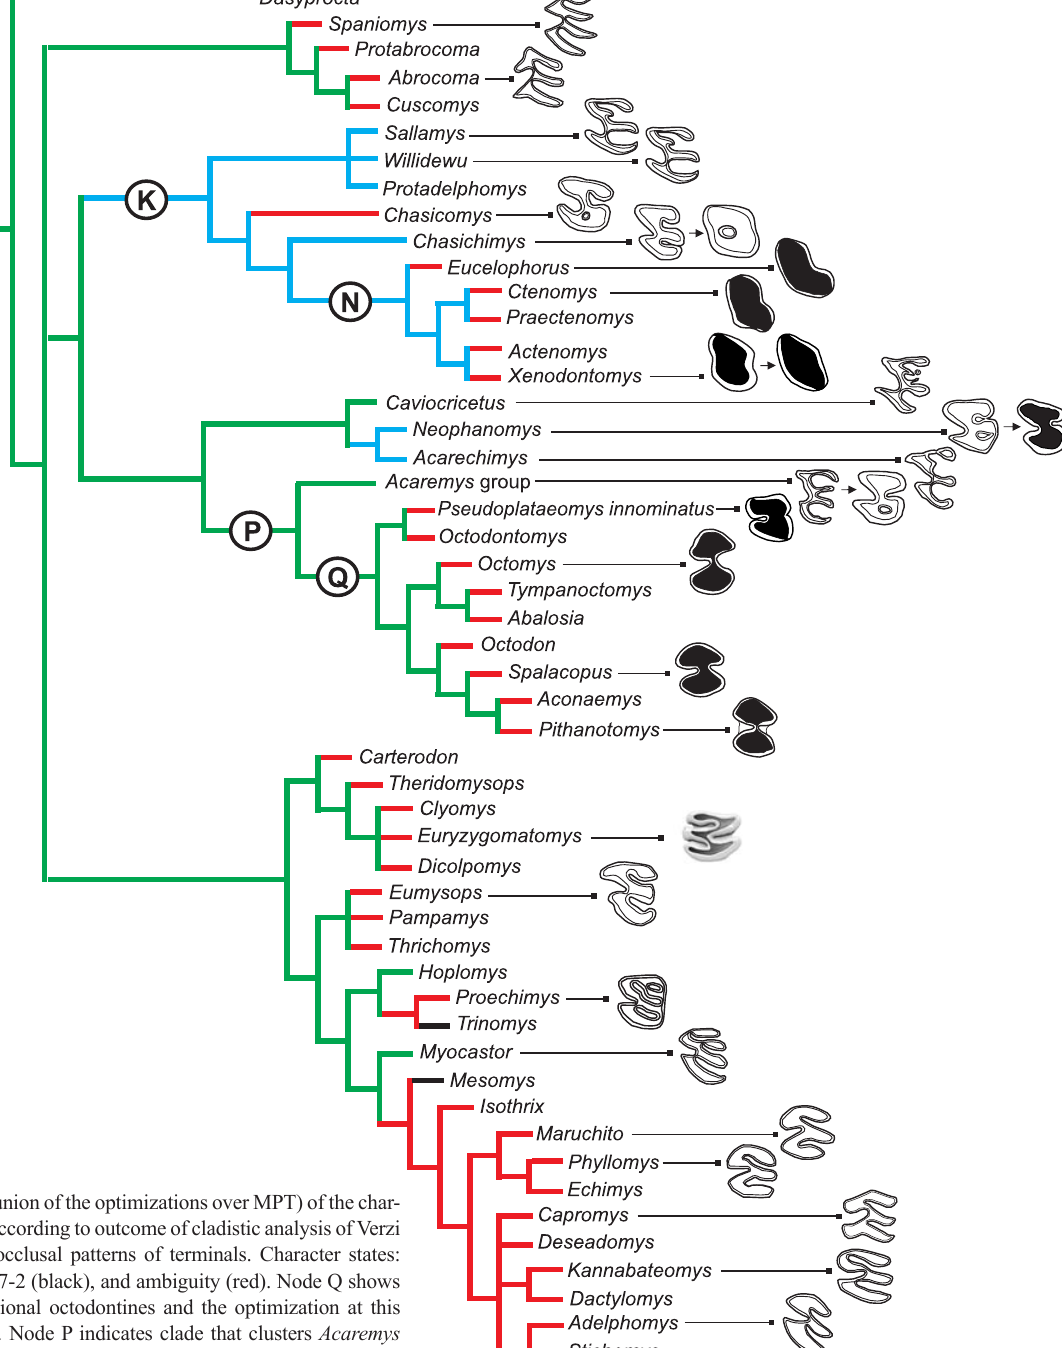
Fig. 3. Common mapping (union of the optimizations over MPT) of the char- acter 67 on the consensus (according to outcome of cladistic analysis of Verzi et al. 2014), showing the occlusal patterns of terminals. Character states: 67-0 (green), 67-1 (blue), 67-2 (black), and ambiguity (red). Node Q shows the clade comprising traditional octodontines and the optimization at this node (character state 67-0). Node P indicates clade that clusters Acaremys and traditional octodontines. Node K (supported by the character-state 67-1; see Verzi et al. 2014: som 1d) indicates the grouping of Protadelphomys – Willidewu – Sallamys , Chasicomys , Chasichimys , and traditional ctenomy- ines (node N). Occlusal figures of terminals represent left m1 or m2 and were essentially modified from Verzi et al. (2014: fig.